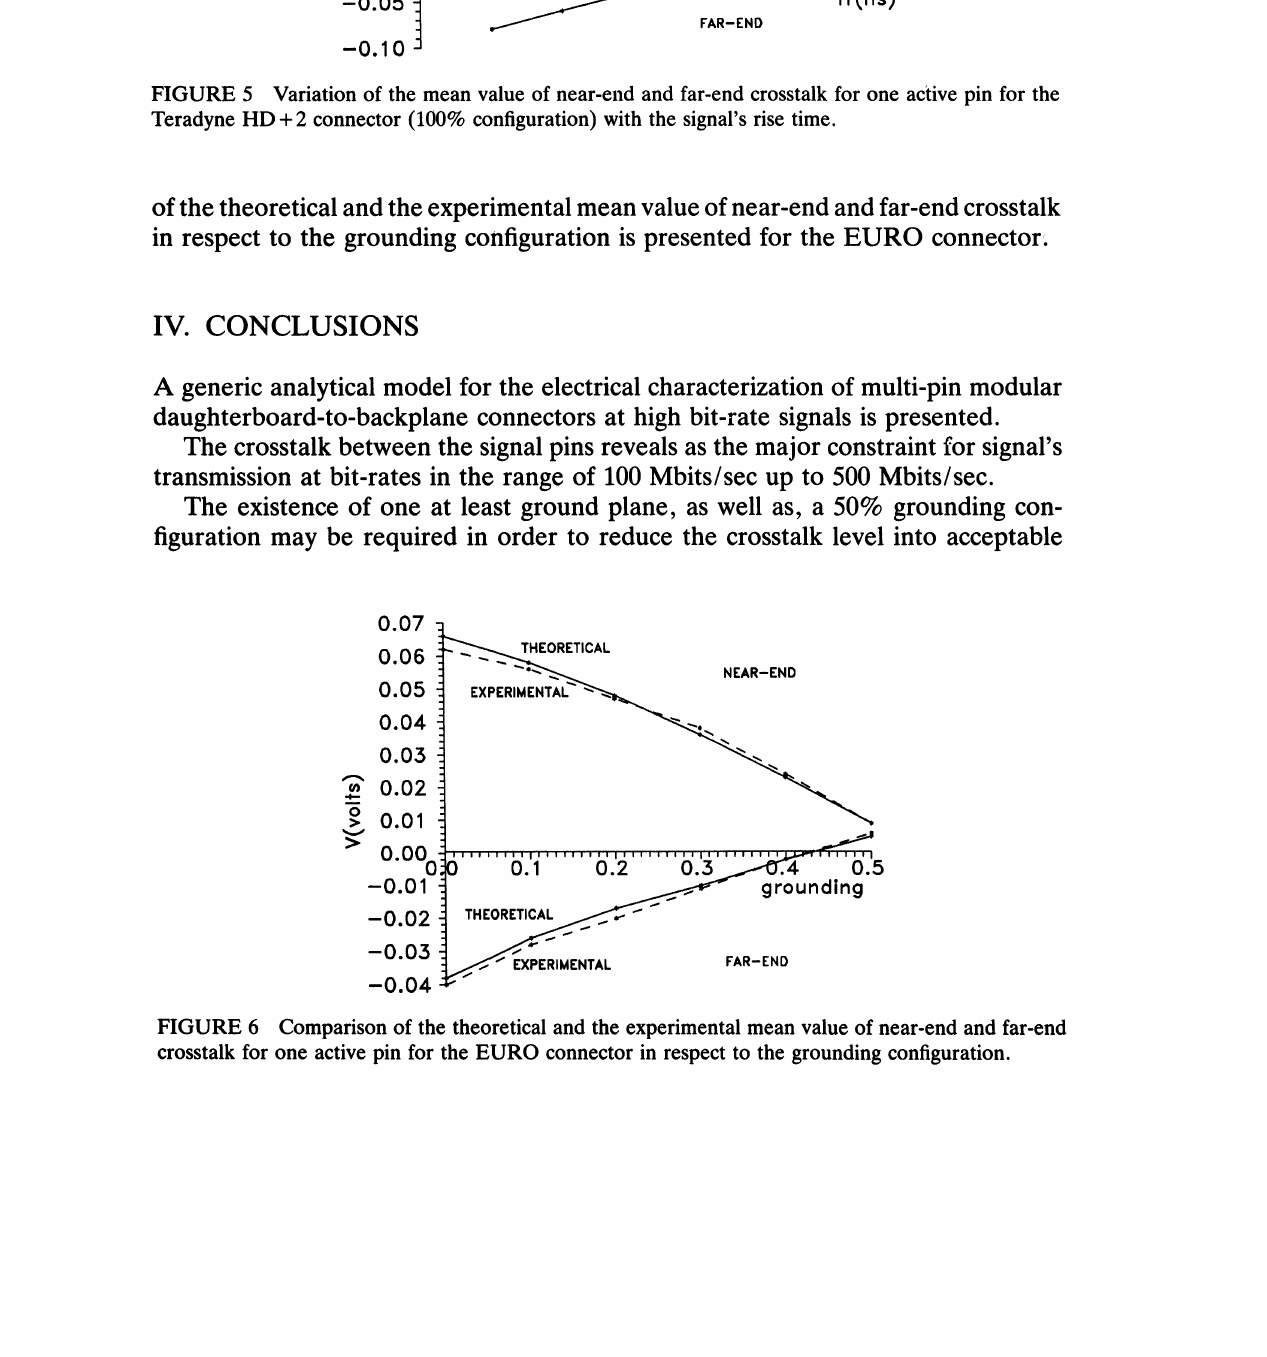
FIGURE 5 Variation of the mean value of near-end and far-end crosstalk for one active pin for the Teradyne HD+ 2 connector (100% configuration)with the signal’s rise time.